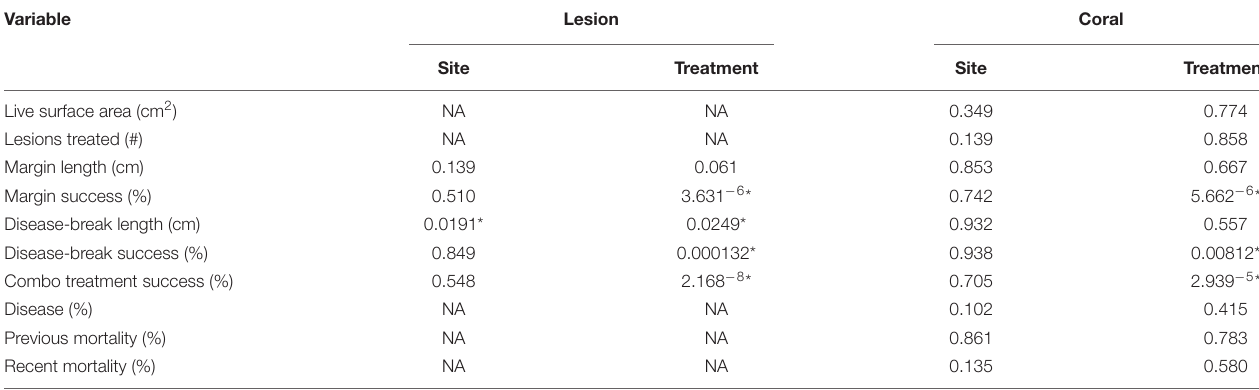
TABLE 1 | Results of the statistical assessment (Kruskal-Wallis p -values) comparing the variable between sites or treatment materials. Variable